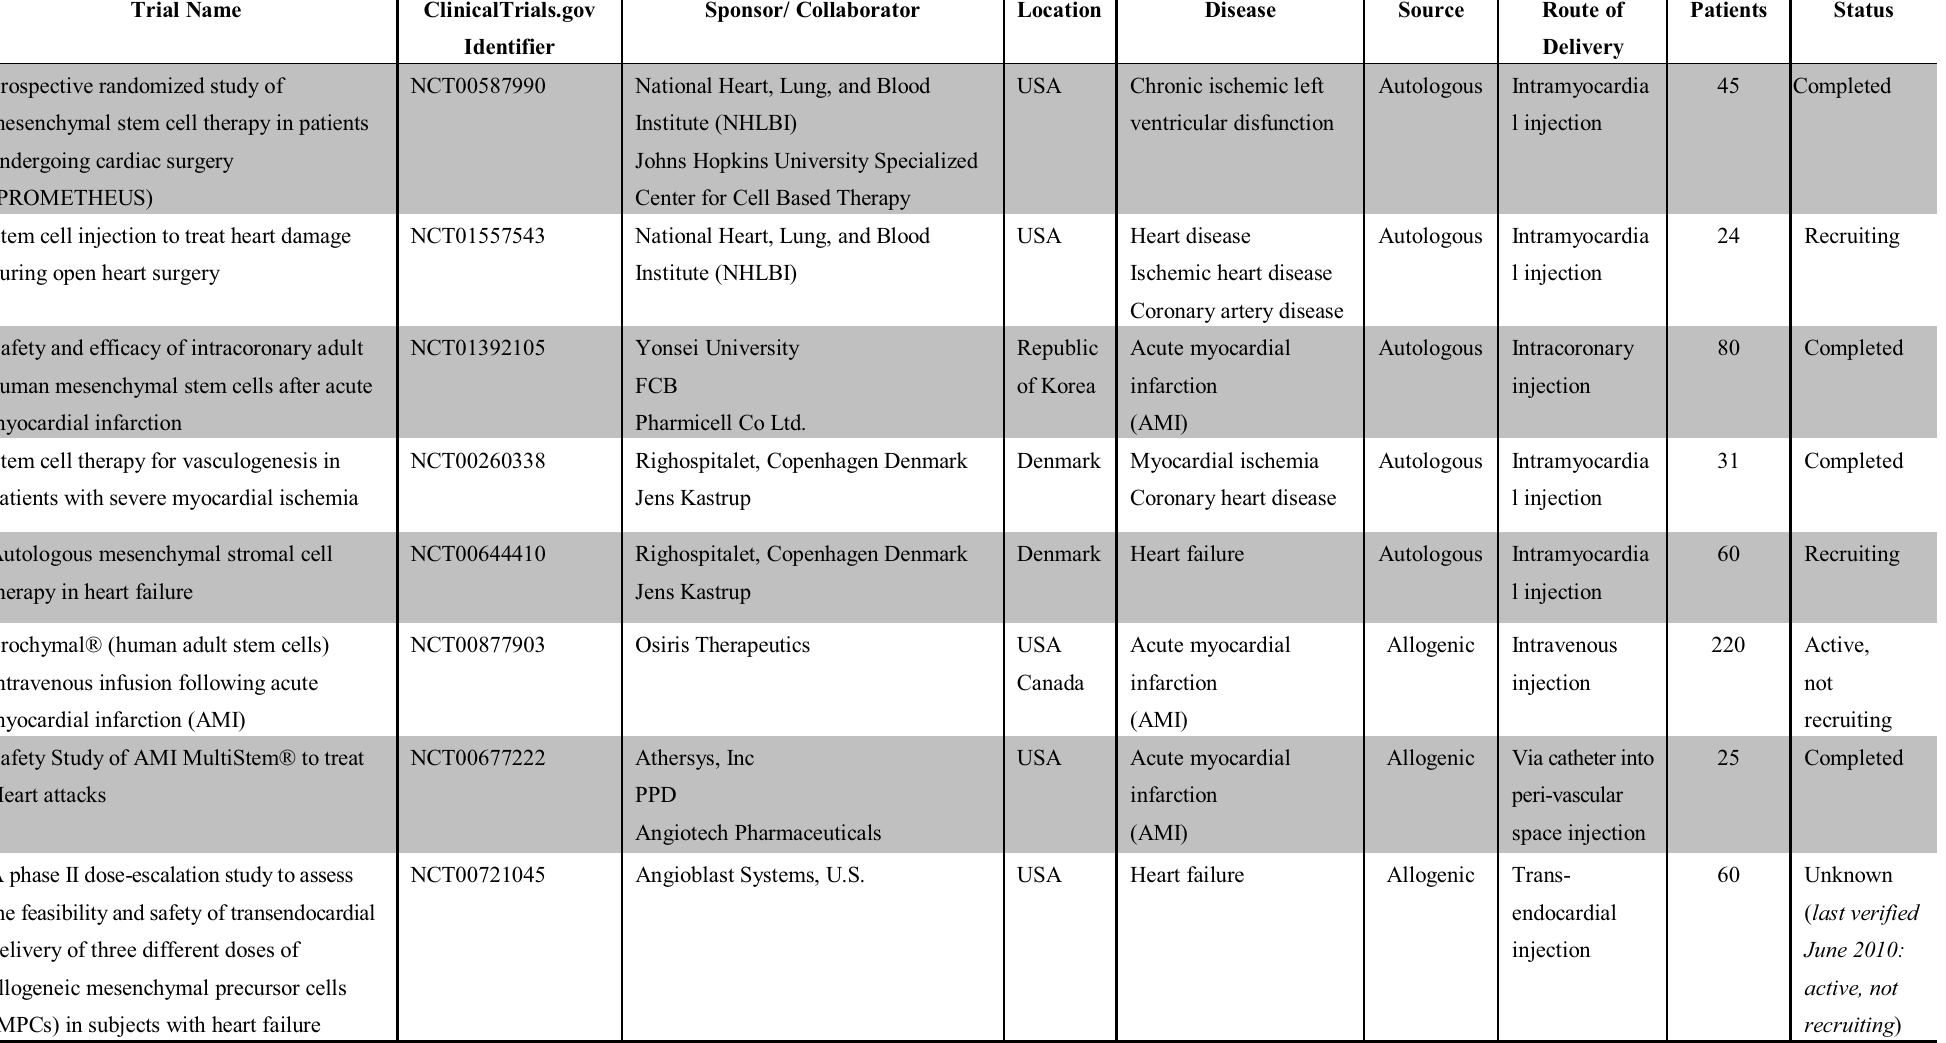
Table 1. Clinical trials using BM-MSC therapy for cardiac